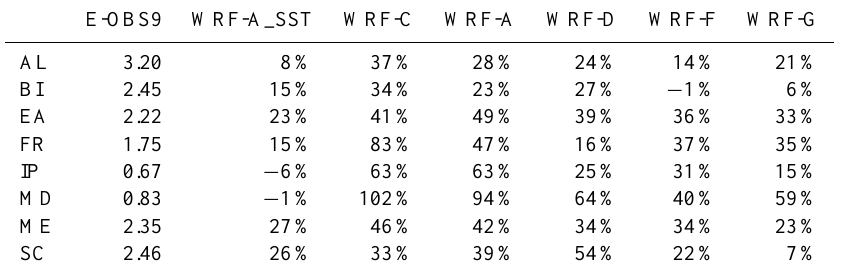
Table 3a. Mean (Mobs) of summer (JJA) precipitation for observations (E-OBS9) over 1990–2008 in the European subregions (units in mmday − 1 ). Model relative bias (%).